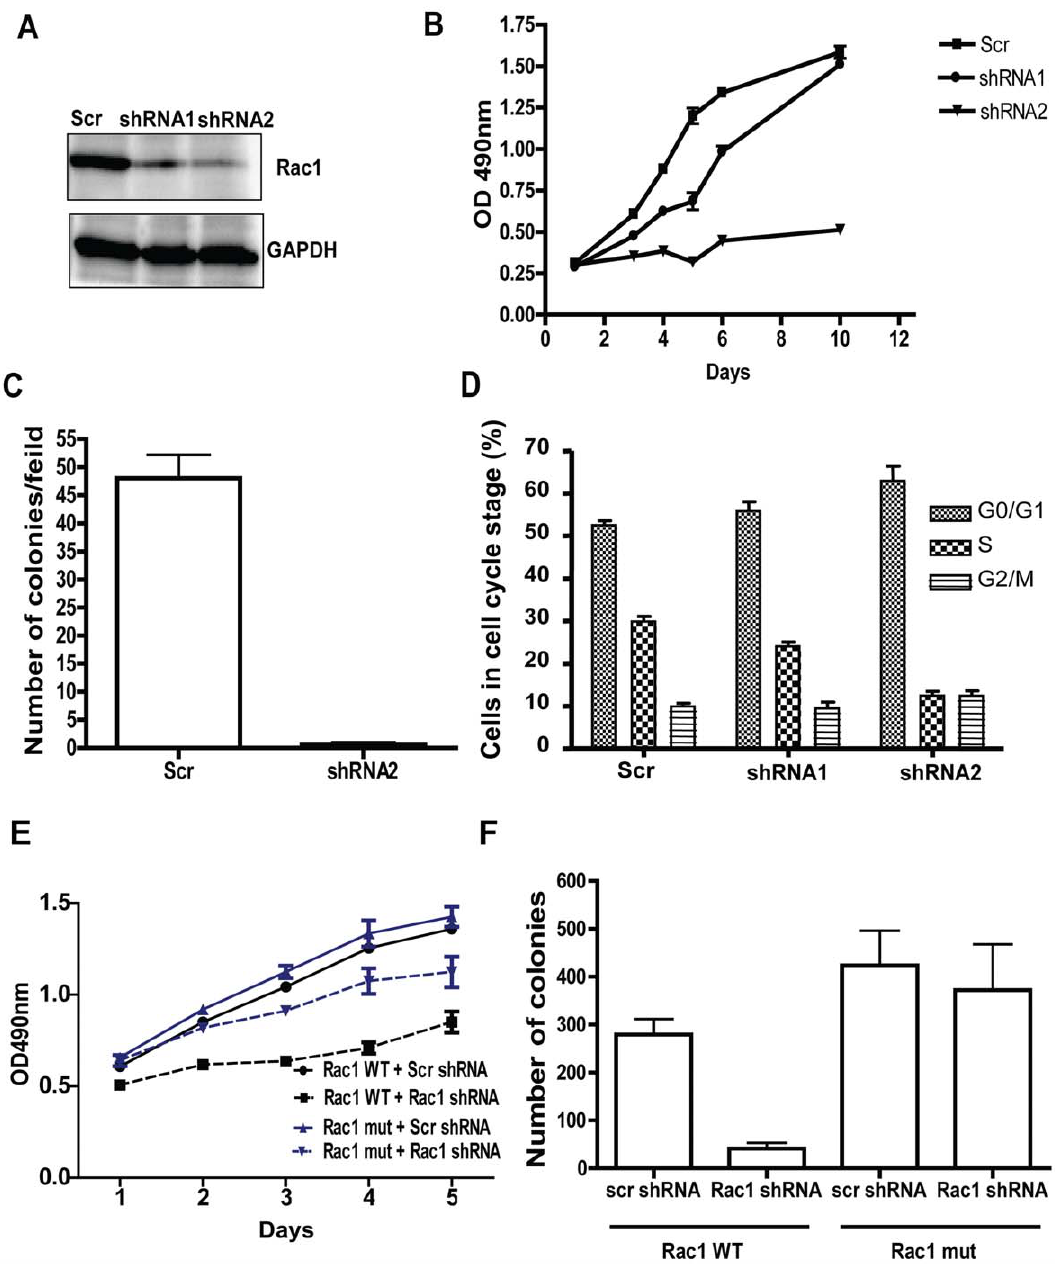
Figure 1. Knocking down Rac1 expression effectively inhibits human non-small cell lung cancer cell proliferation. (A) Cell lysates collected from either scrambled shRNA (Scr) or Rac1 shRNA (shRNA1, shRNA2) A549 cells were subjected to Rac1 western blot analysis. GAPDH was used as loading control. (B) Infected cells were sorted and plated on 96-well plate and proliferation assay was performed using MTS reagent. Assay was performed in triplicates and above is one representative of three independent experiments. (C) Infected cells were sorted, plated for soft agar colony assay and colonies per field were counted after 2 weeks. Assay was performed in triplicates and above is one representative of three independent experiments. (D) Infected cells were sorted and incubated with BrdU in log phase of cell growth. Cells are trypisinized, stained with BrdU antibody, 7AAD and cell cycle analysis was performed using flowcytometry. Assay was performed in triplicates and above is one representative of four independent experiments. Error bars represents SD. (E) Control cells or cells expressing shRNA resistant Rac1 mutant were infected with scr or Rac1 shRNAs, sorted and plated on 96-well plate. Proliferation assay was performed using MTS reagent. Assay was performed in triplicates and above is one representative of two independent experiments. (F) Infected cells were sorted, plated for soft agar colony assay and colonies were counted after 10 days. Assay was performed in triplicates and above is one representative of two independent experiments.